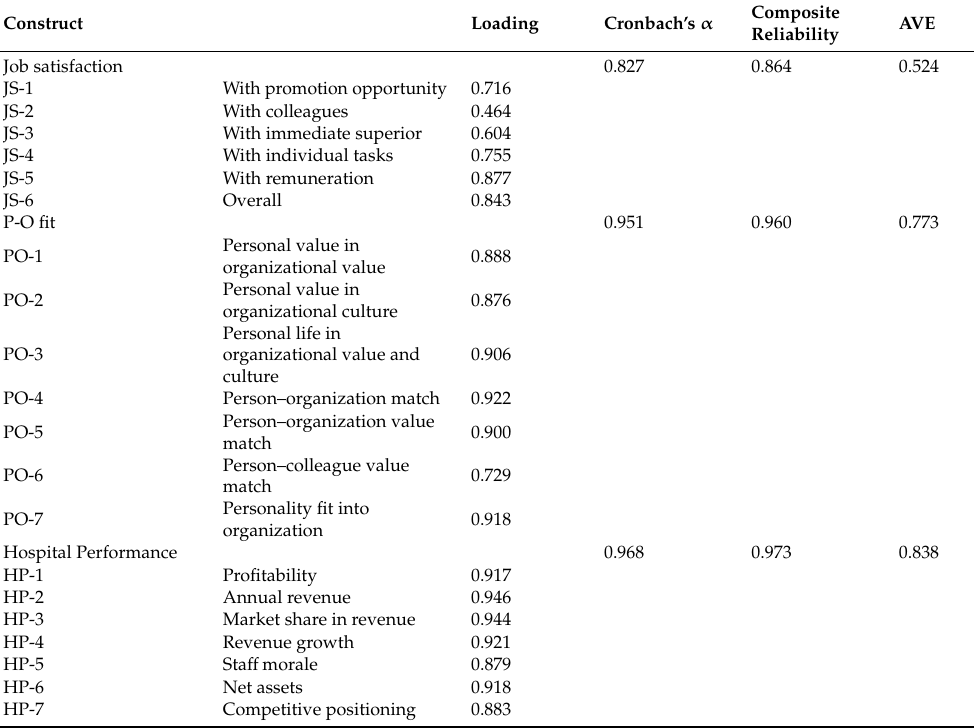
Table 2. Reliability of measurement scales.